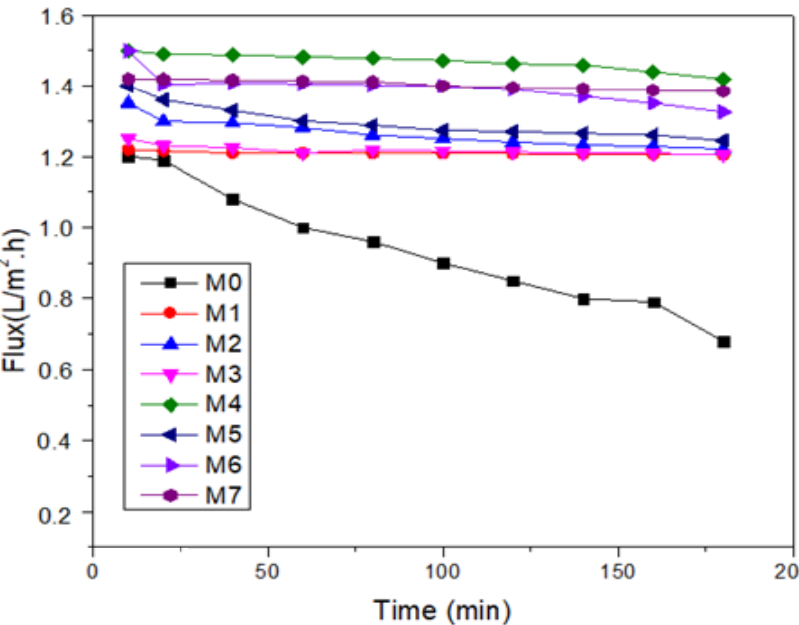
Figure 15. Permeate flux decline during BSA filtration of the prepared NF membranes. Secondly, membrane fouling behaviour was also assessed using flux recovery ratio (FRR) (Figure 16). The pristine membrane, M0, showed the lowest FRR of all the membranes indicative of relatively higher irreversible BSA fouling. The reference PA-TF (M1) membrane also exhibited higher irreversibility at 50%. PA-TFC containing only GO showed the highest FRR (85%) together with the composite with the least amount of ZIF-8 (M4) at 88%. Nonetheless, all the composite membranes containing ZIF-8@GO had FRR above 70% confirming their high fouling resistance as seen earlier.